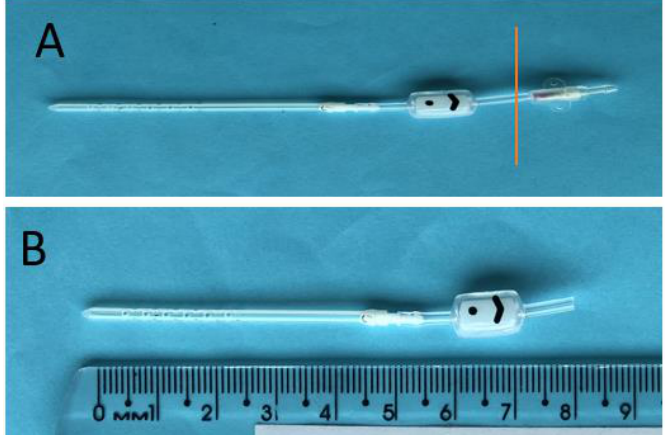
Figure 2. Ventricular catheter connected to the valve system. A. The crossing orange line shows the point the valve is cut off. B. The ready system showing the little reservoir and tinny distal